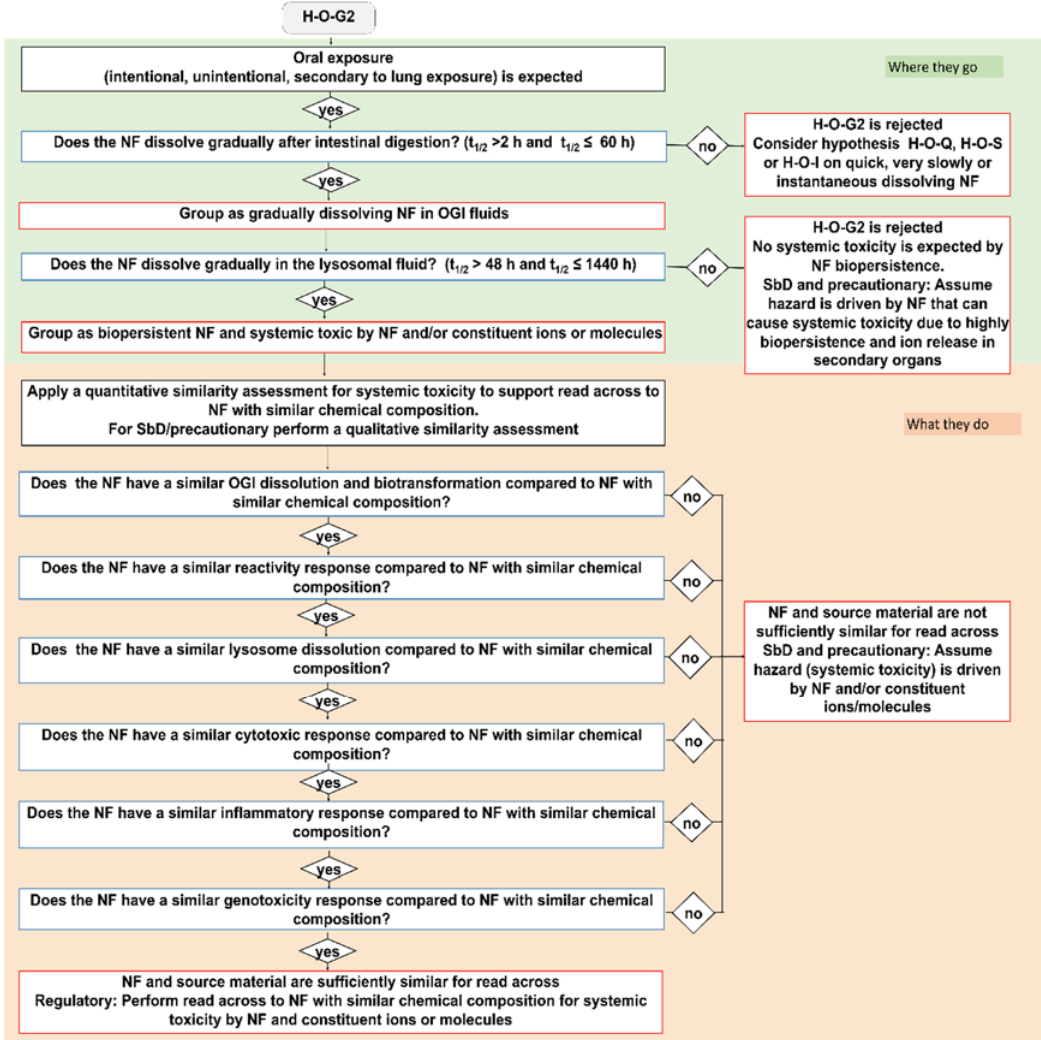
Figure 3. The IATA which addresses the oral ingestion hypothesis H-O-G2: Following oral exposure, both NFs and constituent ions or molecules may translocate to secondary target organs and may lead to systemic toxicity in secondary organs due to biopersistency. Blue bordered boxes are decision nodes, red bordered boxes are hypothesis conclusions, black bordered boxes are considerations.